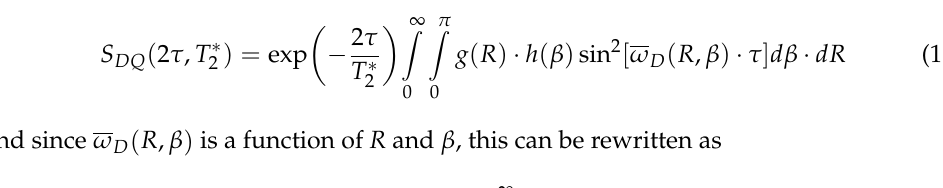
best fit curve (dashed red line) cannot explain the bimodal character of the measured